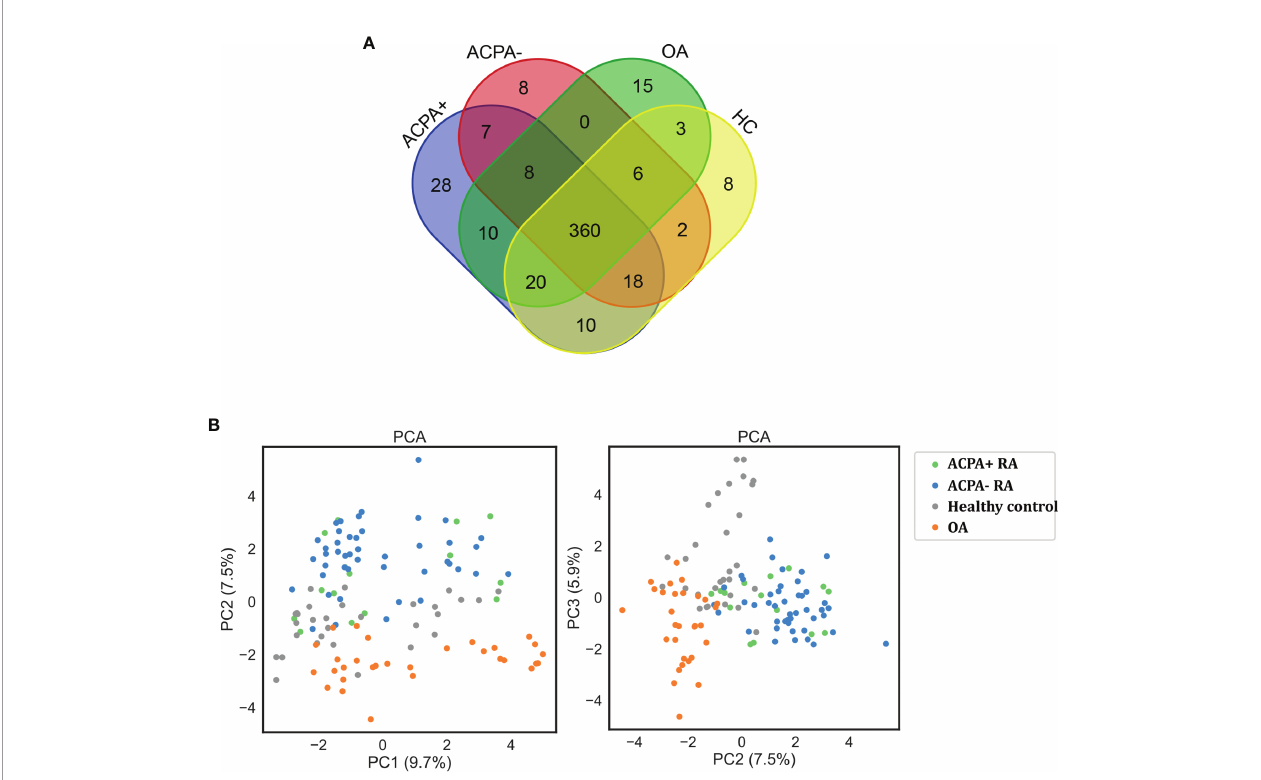
FIGURE 2 | Protein quanti fi cation through LC-MS/MS. (A) Venn diagram of the identi fi ed proteins among RA patients and controls. (B) Clustering analysis of differentially expressed proteins on PCA analysis. ACPA+, ACPA-positive RA; ACPA-, ACPA-negative RA; PCA, principal component